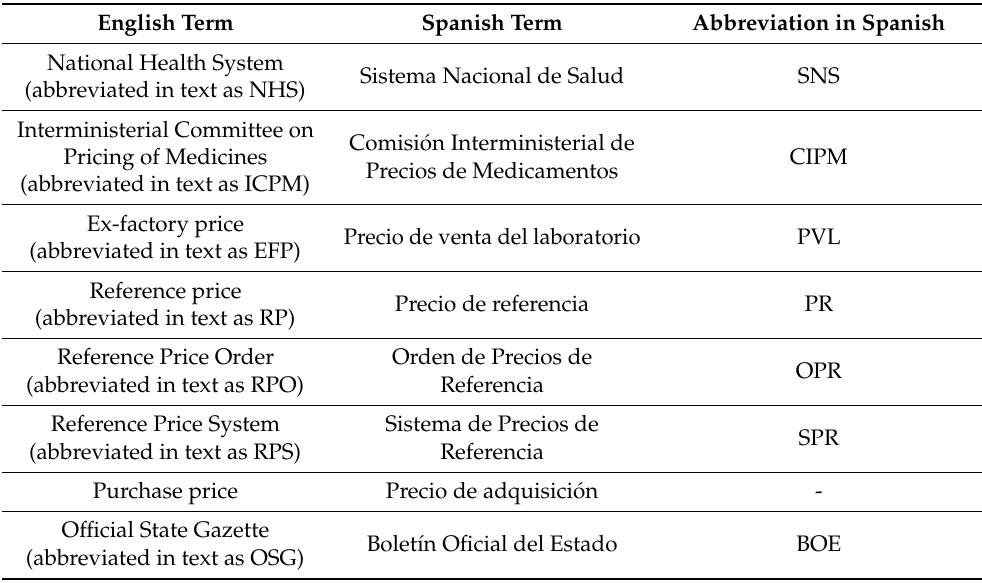
Table 3. Glossary of English/Spanish terms and their